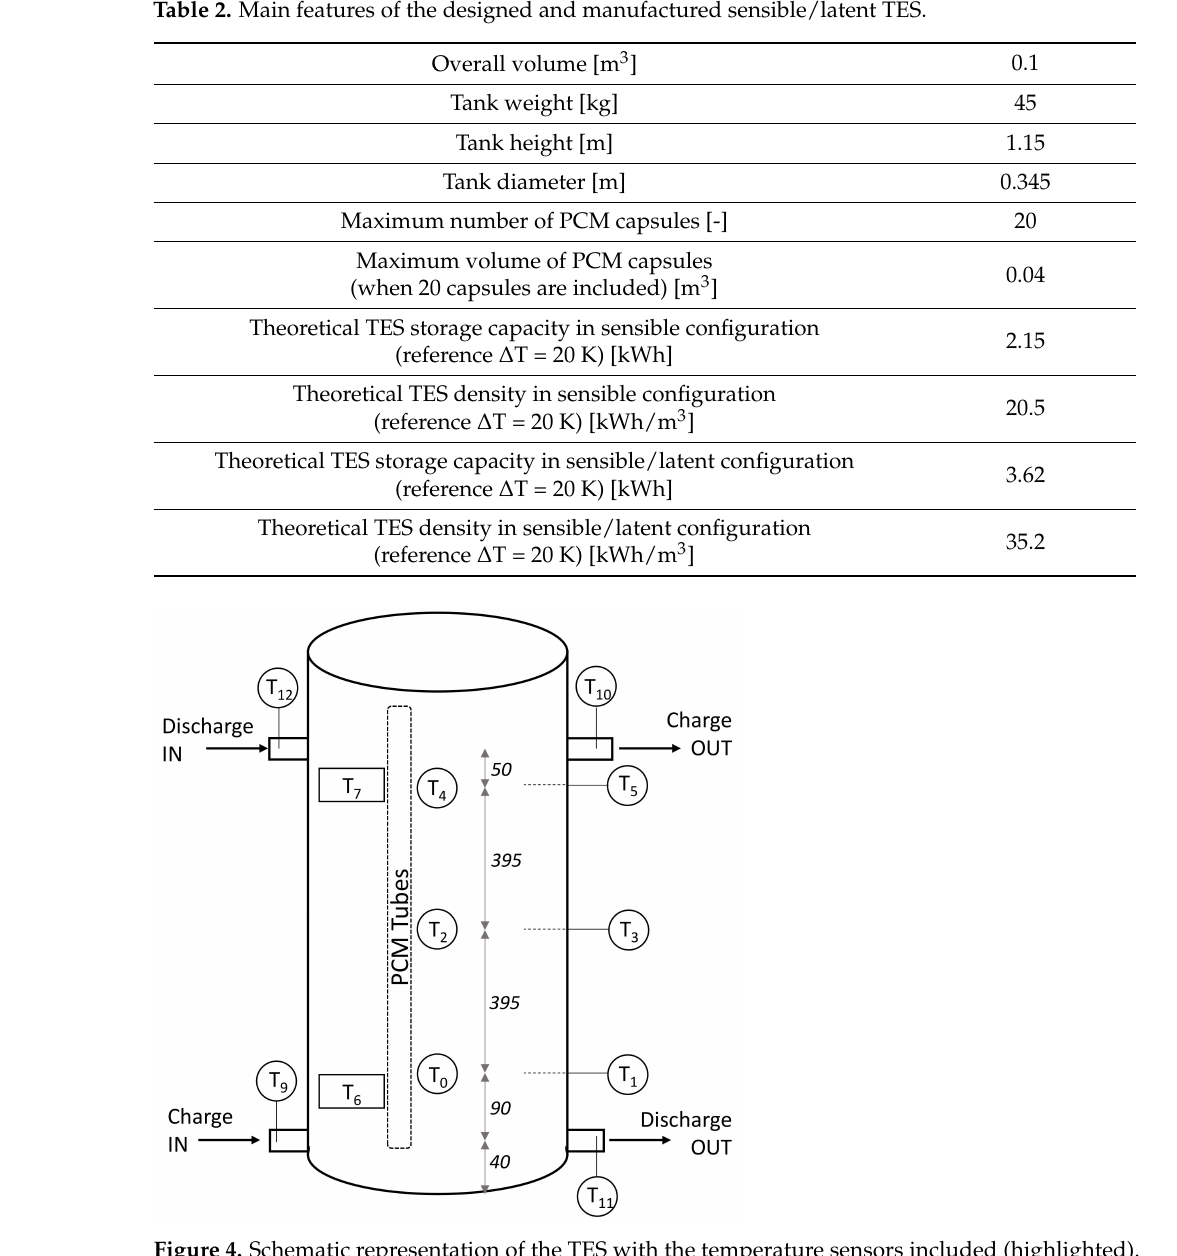
Figure 4. Schematic representation of the TES with the temperature sensors included